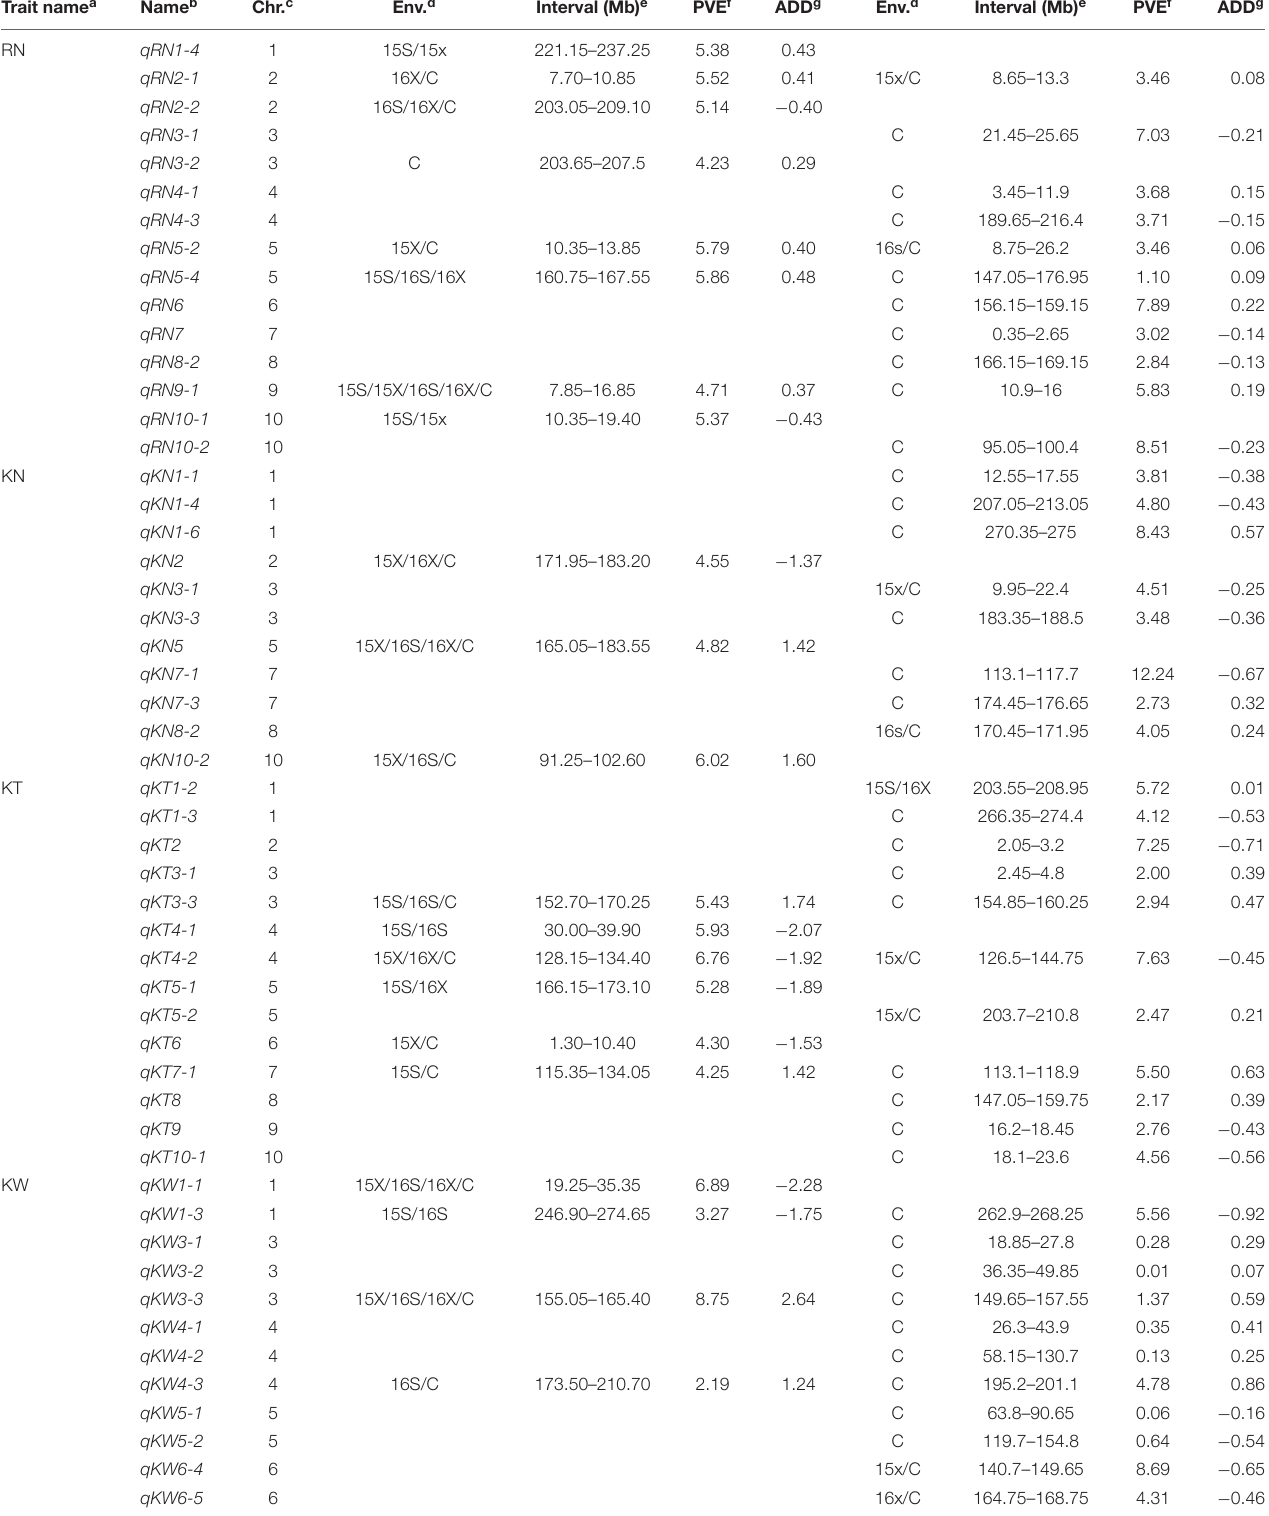
TABLE 4 | QTL and corresponding GCA effects detected for eight yield-related traits in